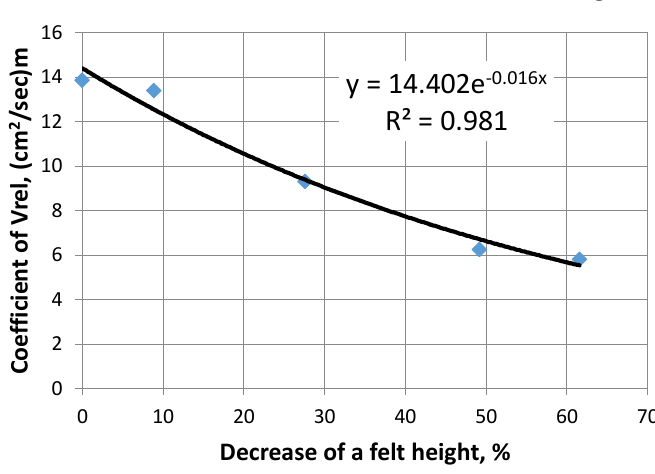
Figure 6. Coefficient of relative velocity through the felt versus decrease of felt width.